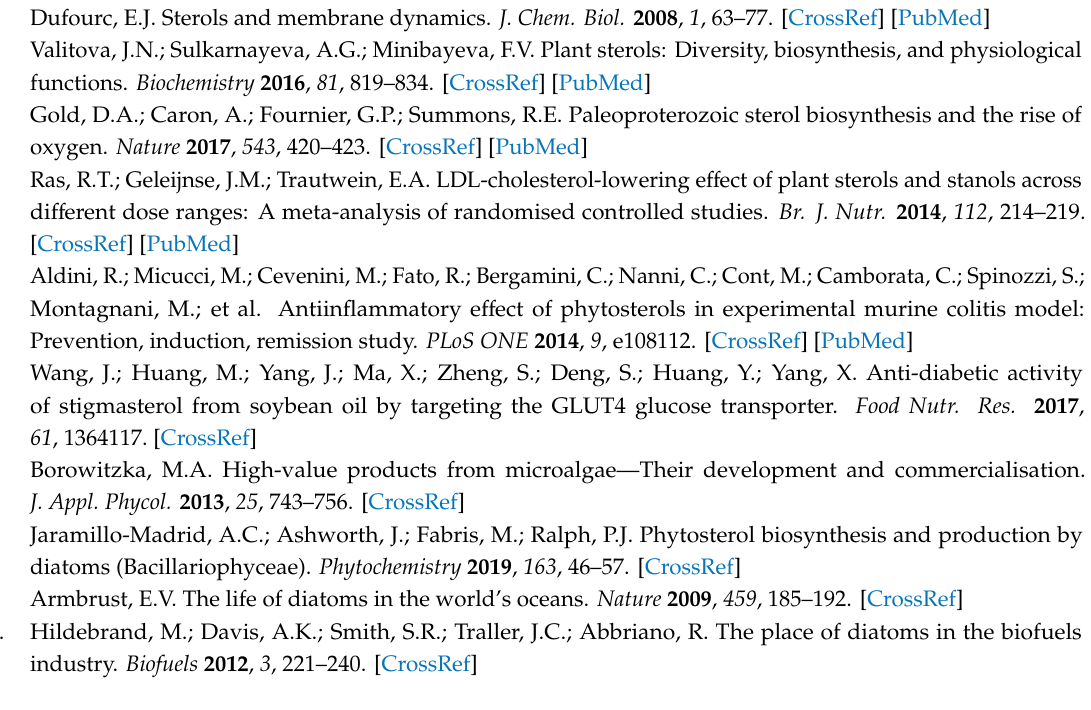
Figure S1. Maps of plasmids used for P. tricornutum transformation, Figure S2. Maps of plasmids used for T. pseudonana transformation, Figure S3. Sequence alignment of HMGR protein (catalytic domain) from model organisms, Figure S4. mVenus fluorescence during full scale experiment in P. tricornutum transformants, Figure S5. mVenus fluorescence during full scale experiment in T. pseudonana transformants, Figure S6. Growth curves during full scale experiment for P. tricornutum transformants, Figure S7. Chlorophyll fluorescence during full scale experiment in P. tricornutum transformants, Figure S8. Maximum quantum yield for P. tricornutum transformants during full scale experiment, Figure S9. Growth curves during full scale experiment for T. pseudonana transformants, Figure S10. Chlorophyll fluorescence during full scale experiment in T. pseudonana transformants, Figure S11. Maximum quantum yield for T. pseudonana transformants during full scale experiment, Figure S12. Sterol levels in T. pseudonana transformants, Table S1. L0 parts for construction of episomes using uLoop assembly method, Table S2. Source and number of transmembrane domains of HMGR sequences used for phylogenetic and domain analysis, HMGR sequences for phylogenetic